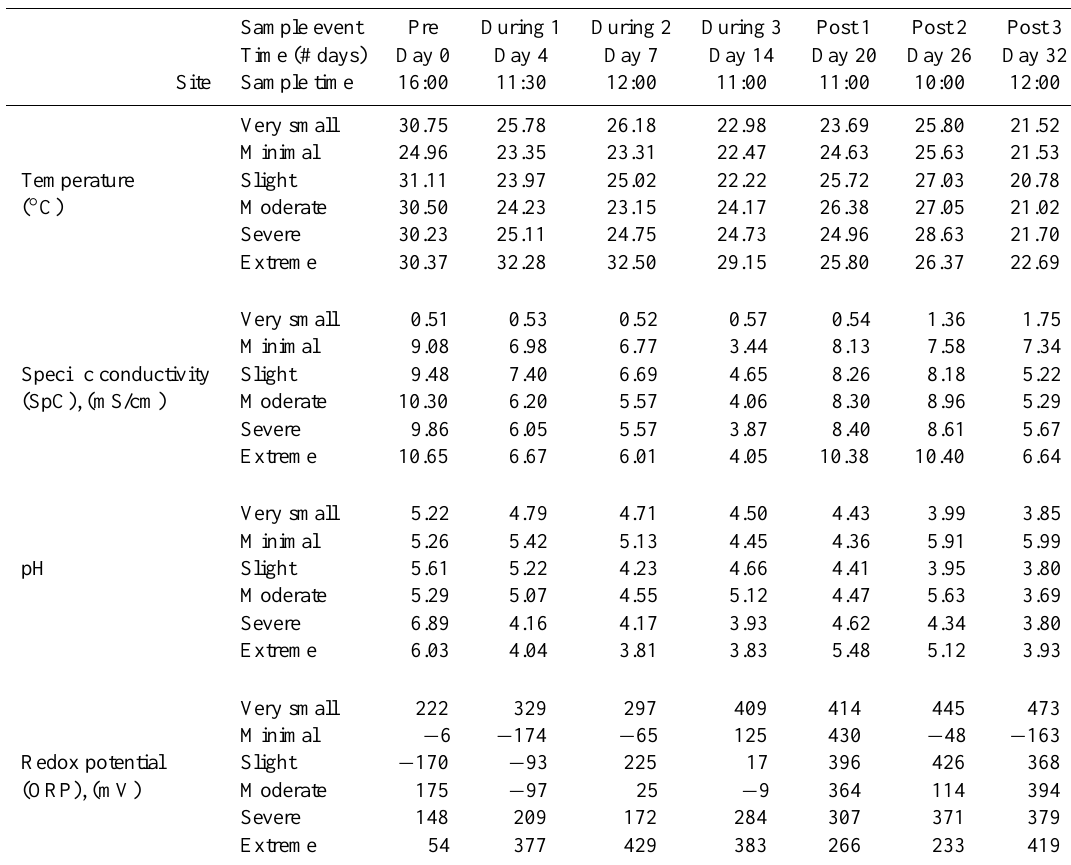
Table 2. Water quality measurements pre-, during-, and post-dewatering.